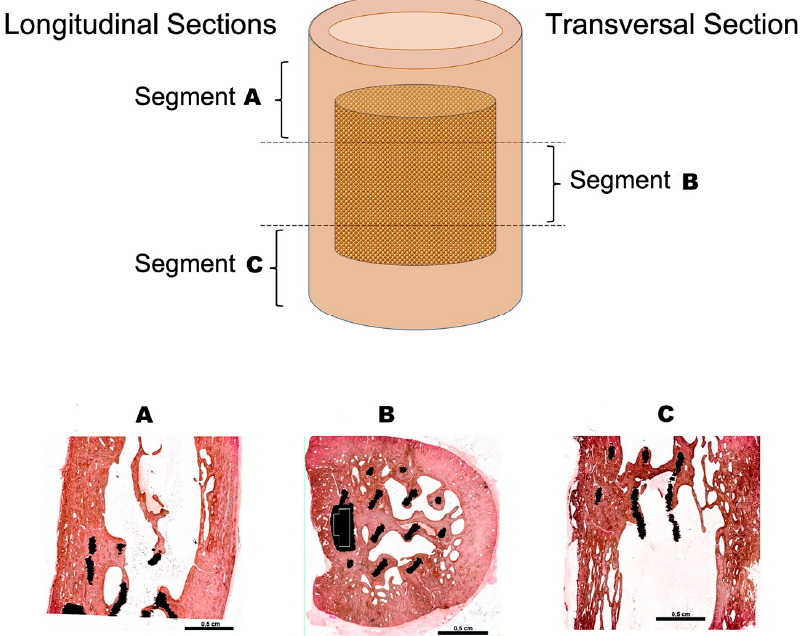
Figure 5. Histological processing of the sheep tibiae from the experimental group. Upper panel: Each bone, containing the implant, was sectioned into three segments. Longitudinal sections were obtained from the ends (segments A and C ), while the central part was cut transversally (segment B ). Lower panel: Panoramic overview of the von Kossa-stained methyl-methacrylate sections. ( A ) and ( C ) are longitudinal sections. ( B ) is a transversal section. The bone is stained in brown, and the titanium of the scaffold appears black in color. Note how the bone trabeculae are connecting the metal bars that compose the porous titanium scaffold.